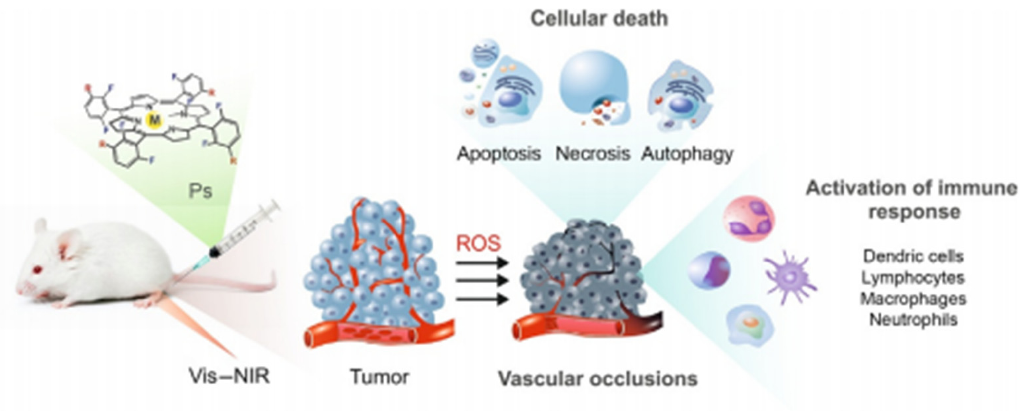
Figure 1. The processes of PDT to destroy the tumor cells (PS means photosensitizer). (Reproduced from [30] with permission from [Elsevier], copyright [2017]) [31].